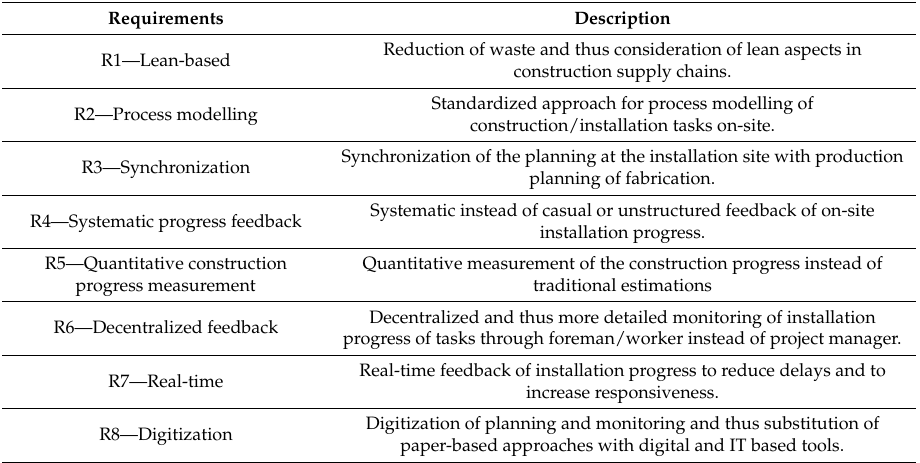
Table 3. Requirements for planning and monitoring in ETO construction.